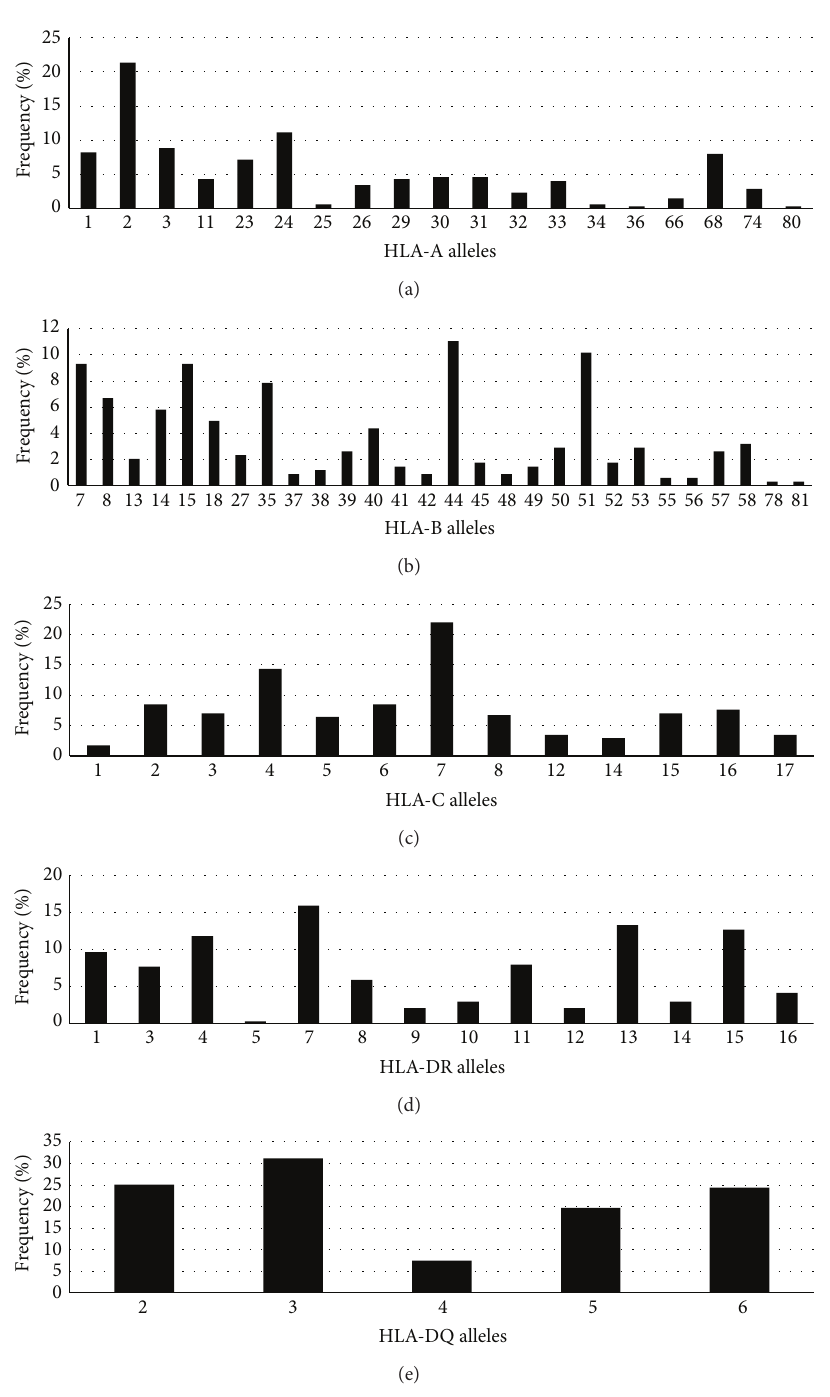
Figure 1: General frequency for HLA in the study population. (a) HLA-A, (b) HLA-B, (c) HLA-C, (d) HLA-DR, and (e) HLA-DQ.